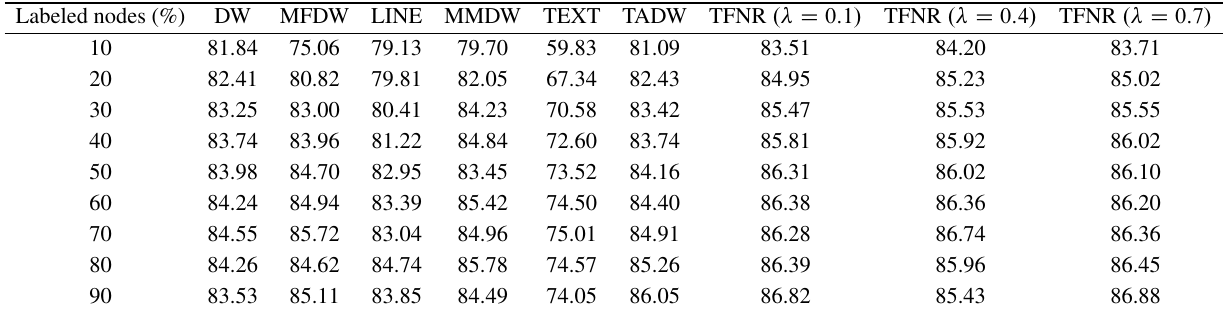
Table 4 Accuracy of vertex classification on